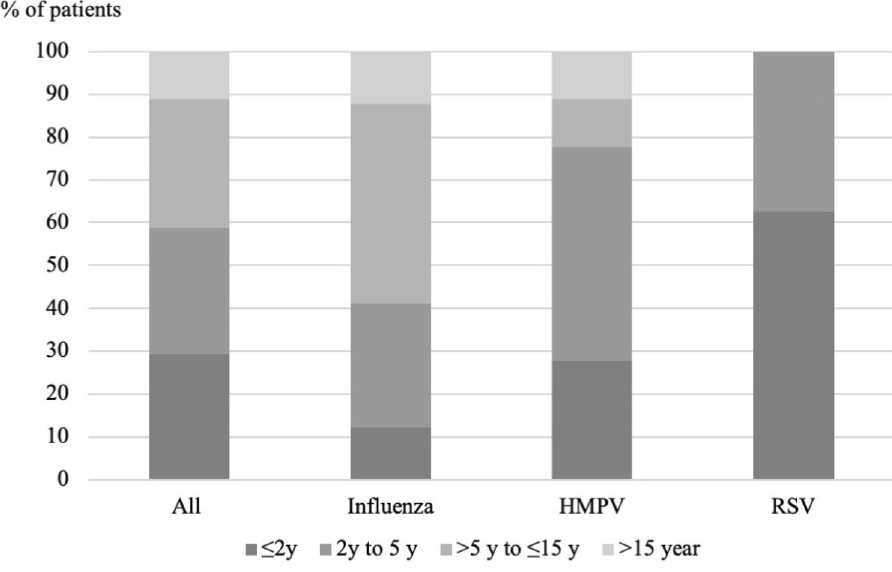
Figure 4. Age distribution in all ARI patients and in patients positive for influenza viruses, respiratory syncytial virus (RSV) and human metapneumovirus (HMPV).